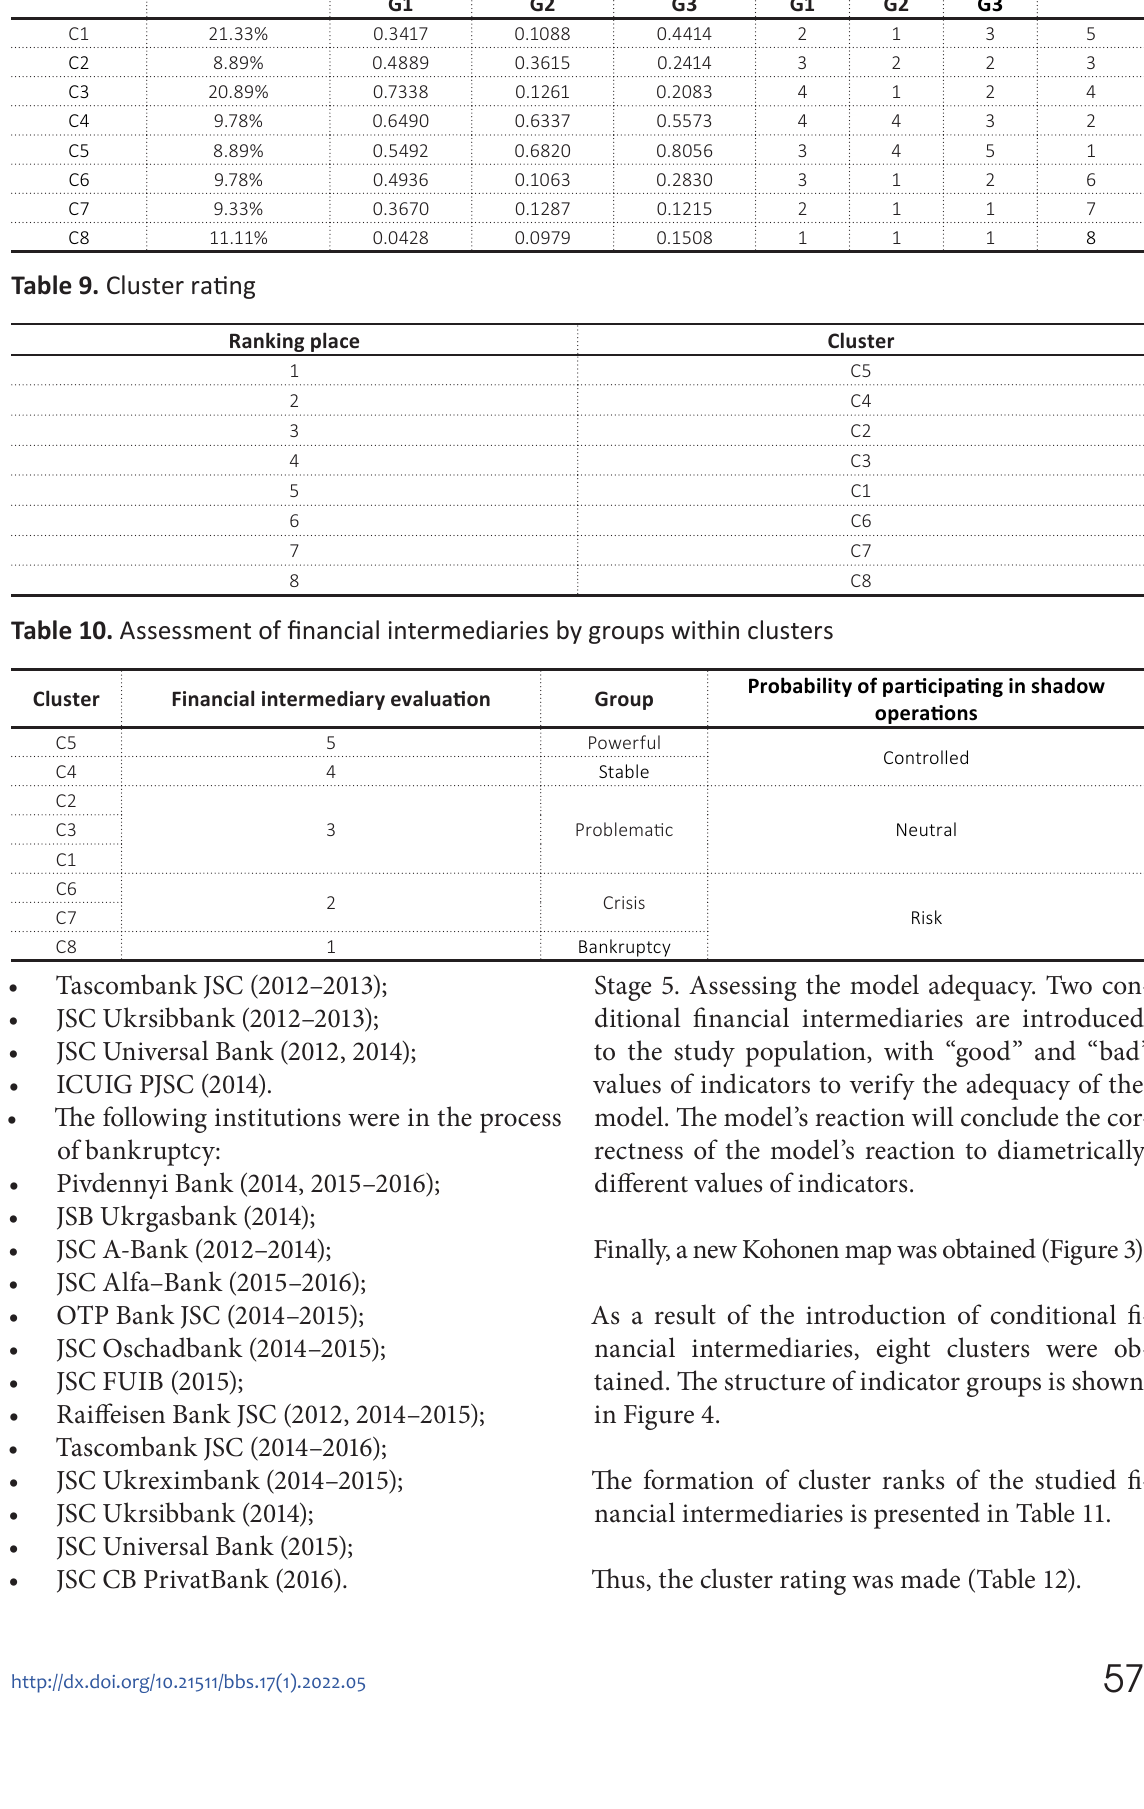
Table 8. Cluster rank formation